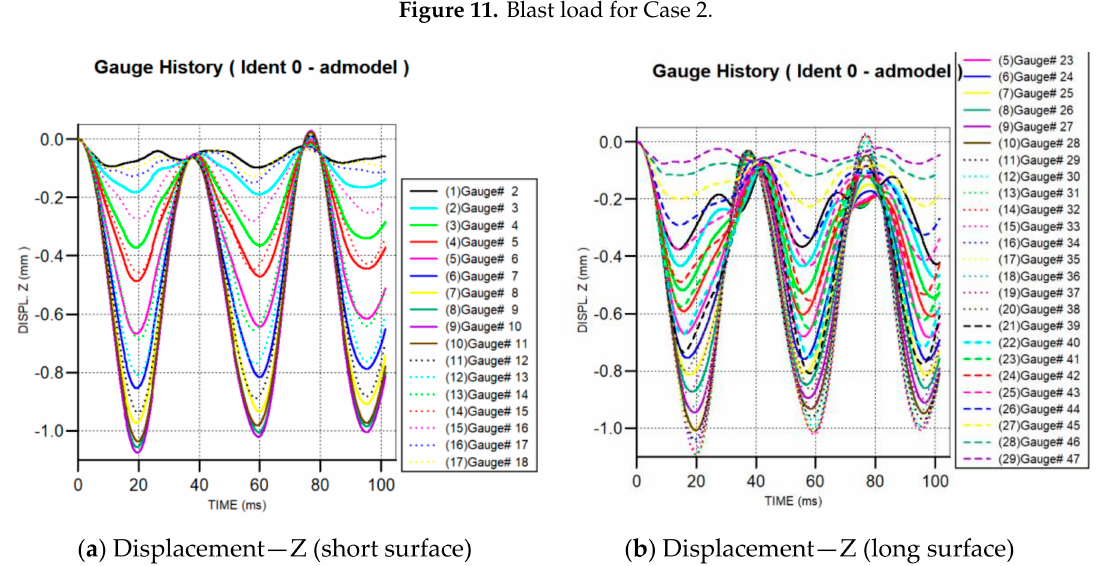
Figure 11. Blast load for Case 2.